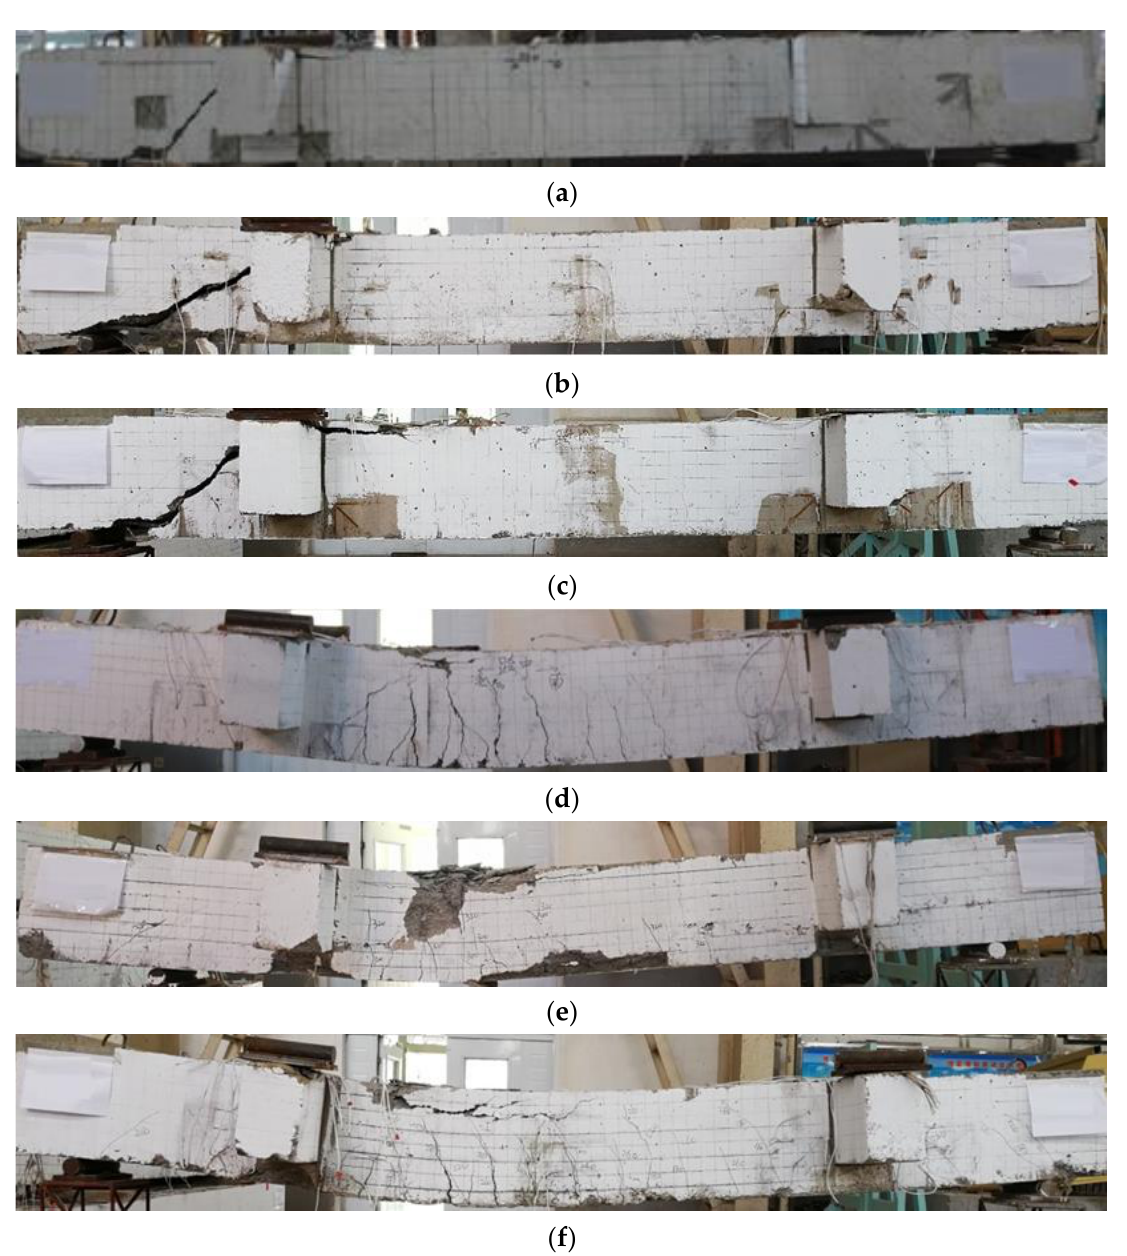
Figure 9. Crack patterns at failure: ( a ) CWJJL1, ( b ) JJLH1, ( c ) JJLH2, ( d ) CWJJL2, ( e ) JJLH3, and ( f ) JJLH4.